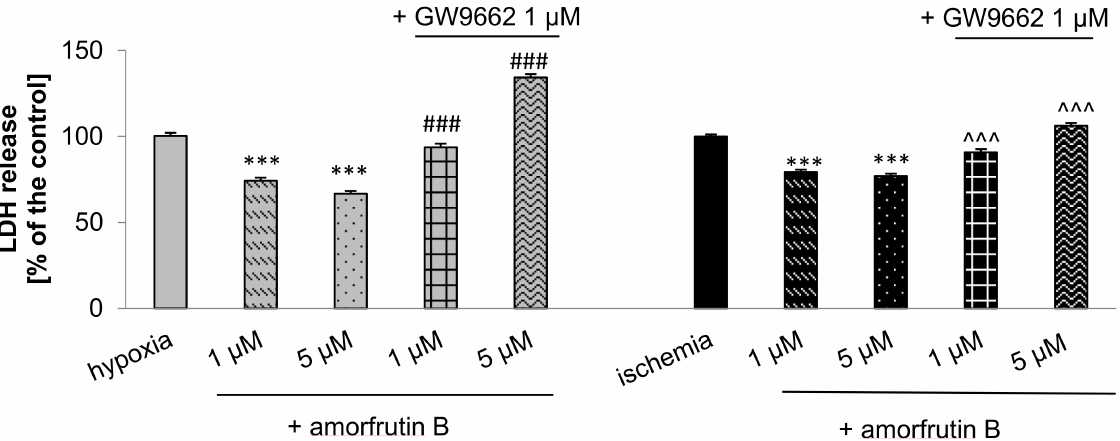
Figure 4. PPAR γ antagonist (GW9662) reduced the neuroprotective effects of 1 and 5 µ M amorfrutin B in the models of hypoxia and ischemia, which was manifested by elevated levels of LDH release. Neuronal cells were treated with GW9662 (1 µ M) 6 h after hypoxia or ischemia for 40 min and subjected to amorfrutin B (1 or 5 µ M) for the next 18 h of reoxygenation. The results are presented as a percentage of the control ± SEM of 3 independent experiments, consisting of 6–8 replicates per group. *** p < 0.001 compared to the control group, ### p < 0.001 compared to the cultures exposed to hypoxia, ˆˆˆ p < 0.001 compared to the cultures exposed to